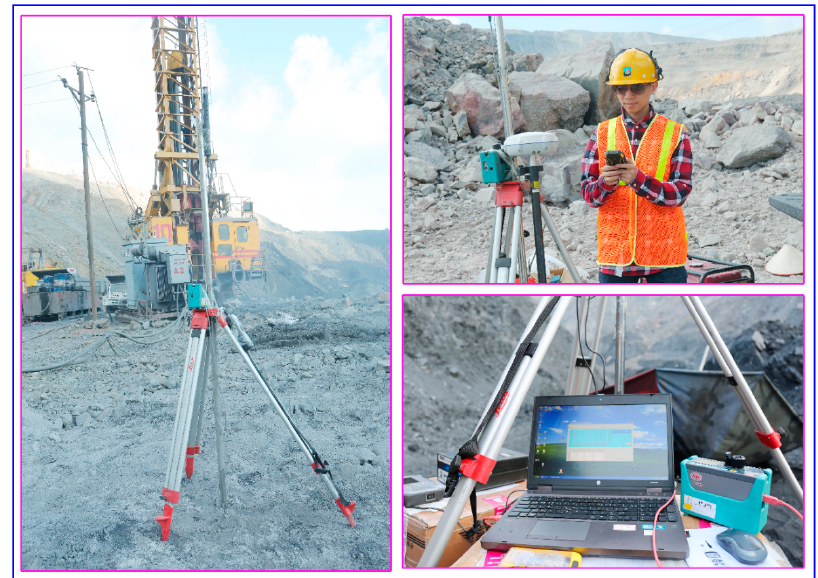
Figure 4. Data collection at the Coc Sau open-pit coal mine for this study. Appl. Sci. 2019 , 9 , x